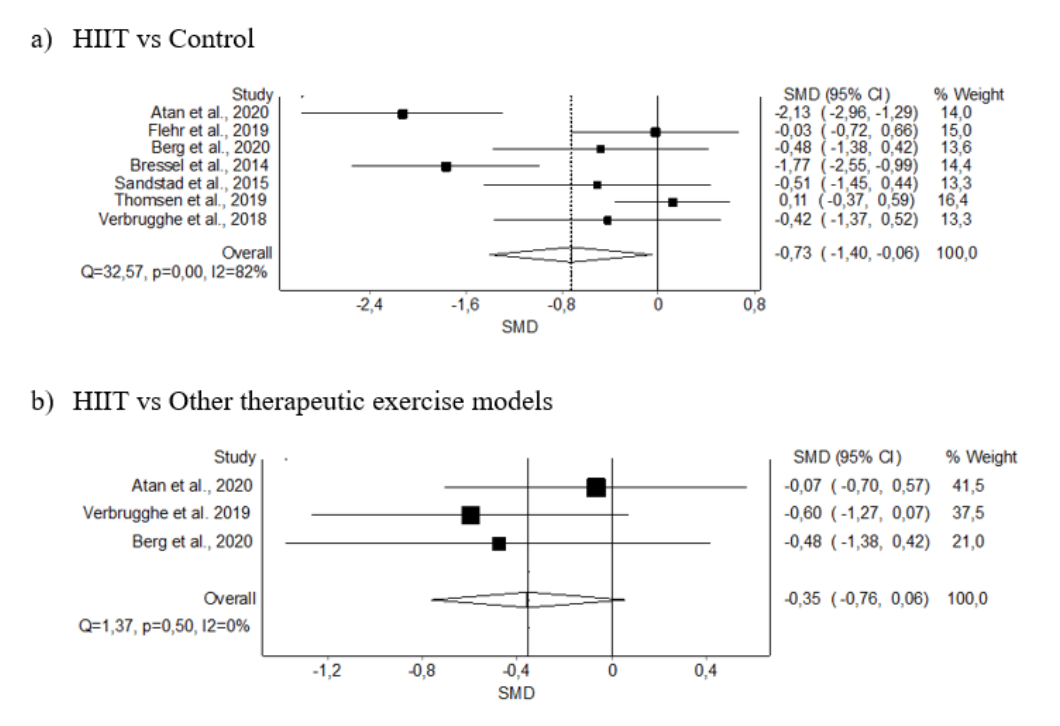
Figure 4. Synthesis forest plot of pain intensity variable. The forest plot summarises the results of the included studies (sample size, standardised mean differences [SMDs], and weight). The small boxes with the squares represent the point estimate of the effect size and sample size. The lines on either side of the box represent a 95% confidence interval (CI). Table 4. Summary of findings and quality of evidence